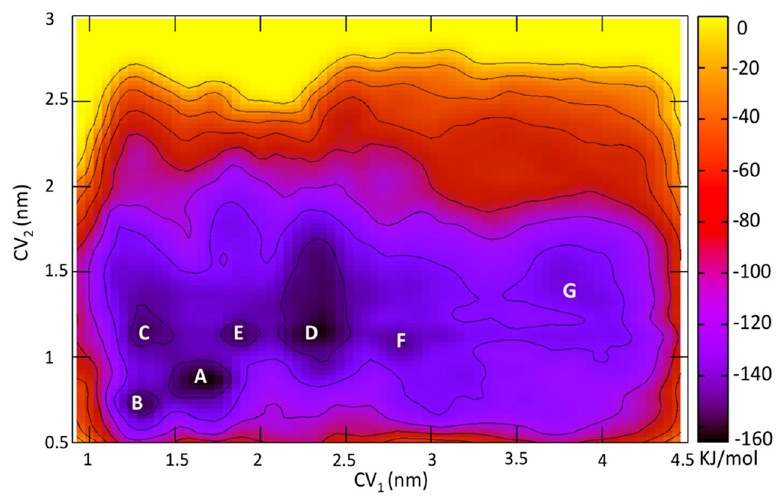
Figure 3. Free-energy surface associated with ZMA/hA 2A R interactions, as a function of collective variables, CV 1 —a measure of ligand-OBS distance and CV 2 —a measure of the E169 ECL2 –H264 7.29 distance. The figure shows the minima associated with the ligand located in the OBS A – C , in the vestibular binding site D in the salt bridge E and in a solvent-exposed moiety of the ECL2 F . In the OBS, the free energy in B and C are higher than that in A by 10.0 and 14.6 kJ/mol, respectively. G indicates the unbound